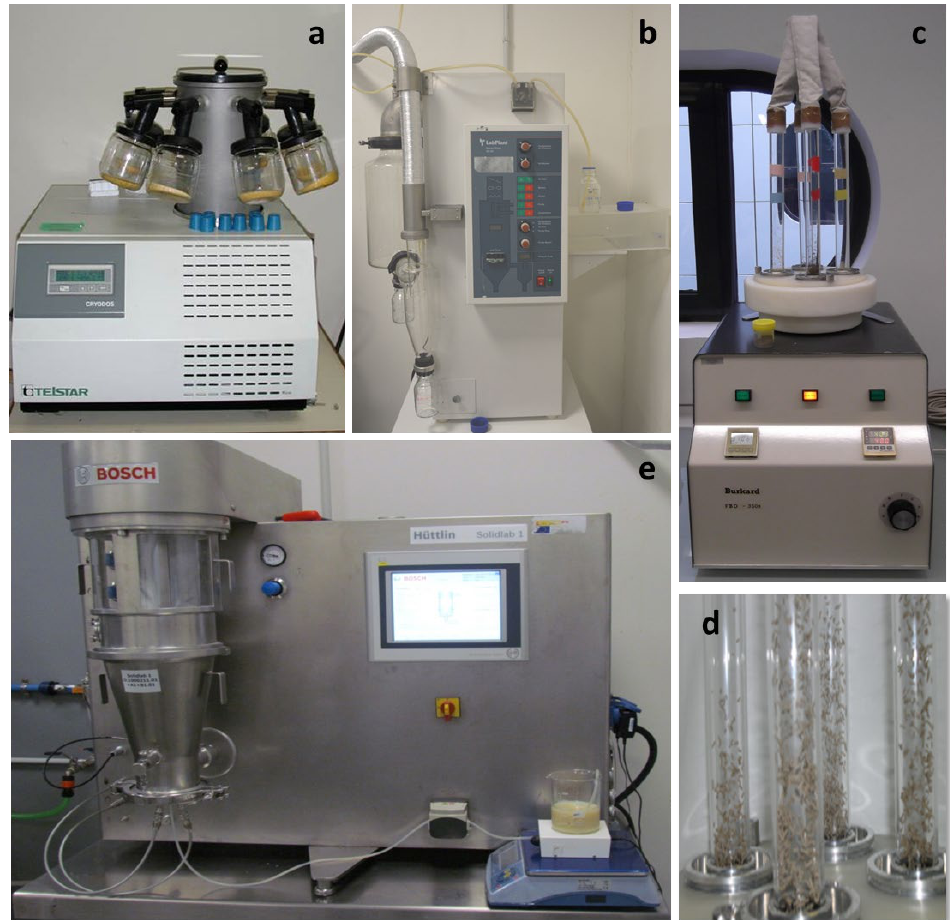
Figure 4. Different dehydration systems used to formulate microorganisms. ( a ) Freeze-dryer, ( b ) spray-dryer, ( c ) fluidized bed-dryer, ( d ) detail of fluidized bed dryer and ( e ) fluidized bed spray- dryer.